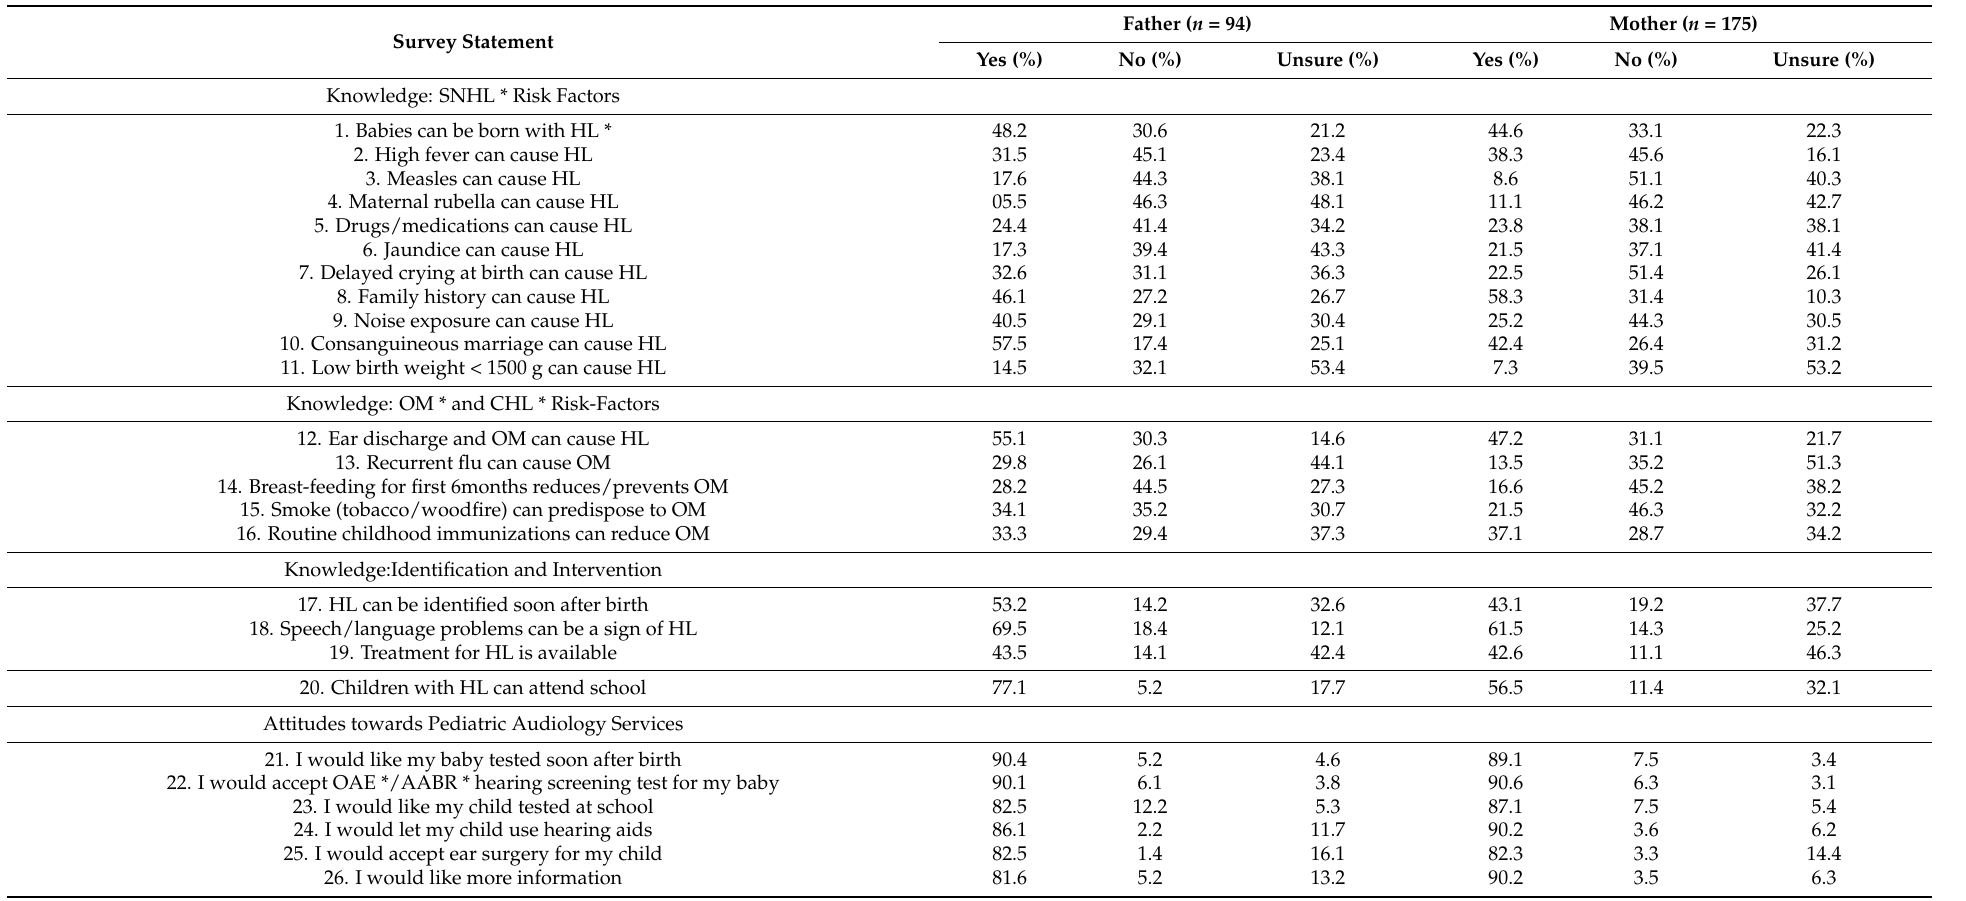
Table 1. Knowledge and attitudes of the parents towards childhood hearing loss and pediatric hearing